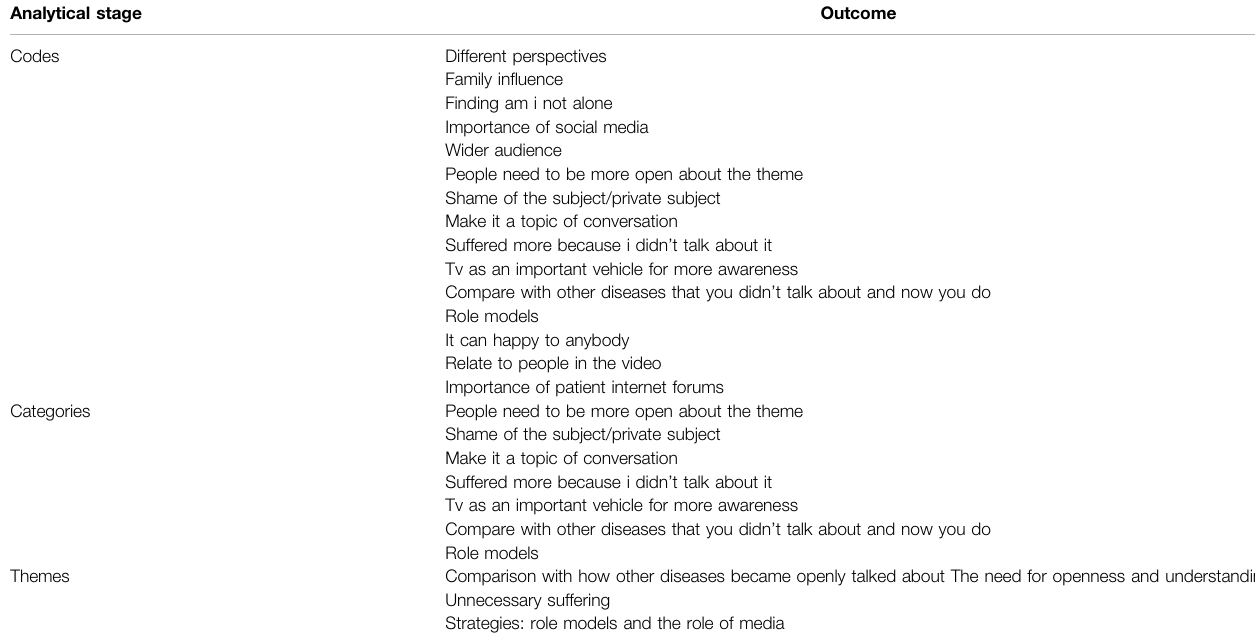
TABLE 2 | Qualitative codes, categories and themes. Analytical